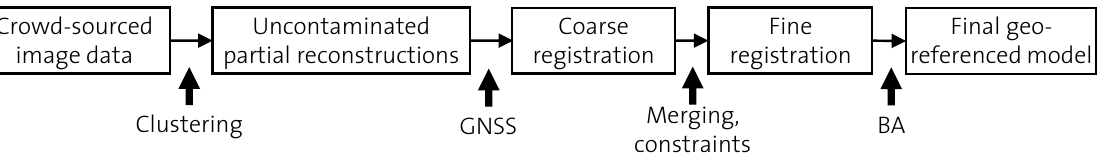
Figure 2. Overview of the proposed